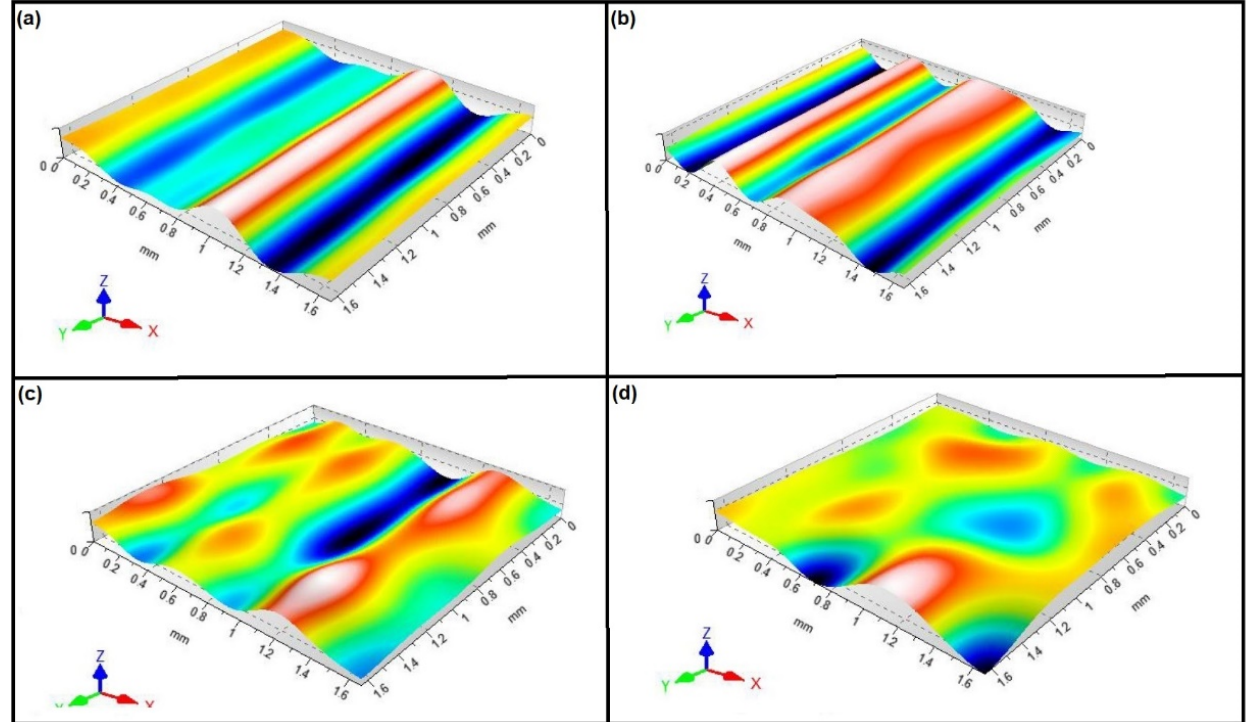
Figure 6. The 3D surface waviness of the inner ring races after the following stages of machining: ( a ) forging, ( b ) turning, ( c ) heat treatment, ( d ) grinding.